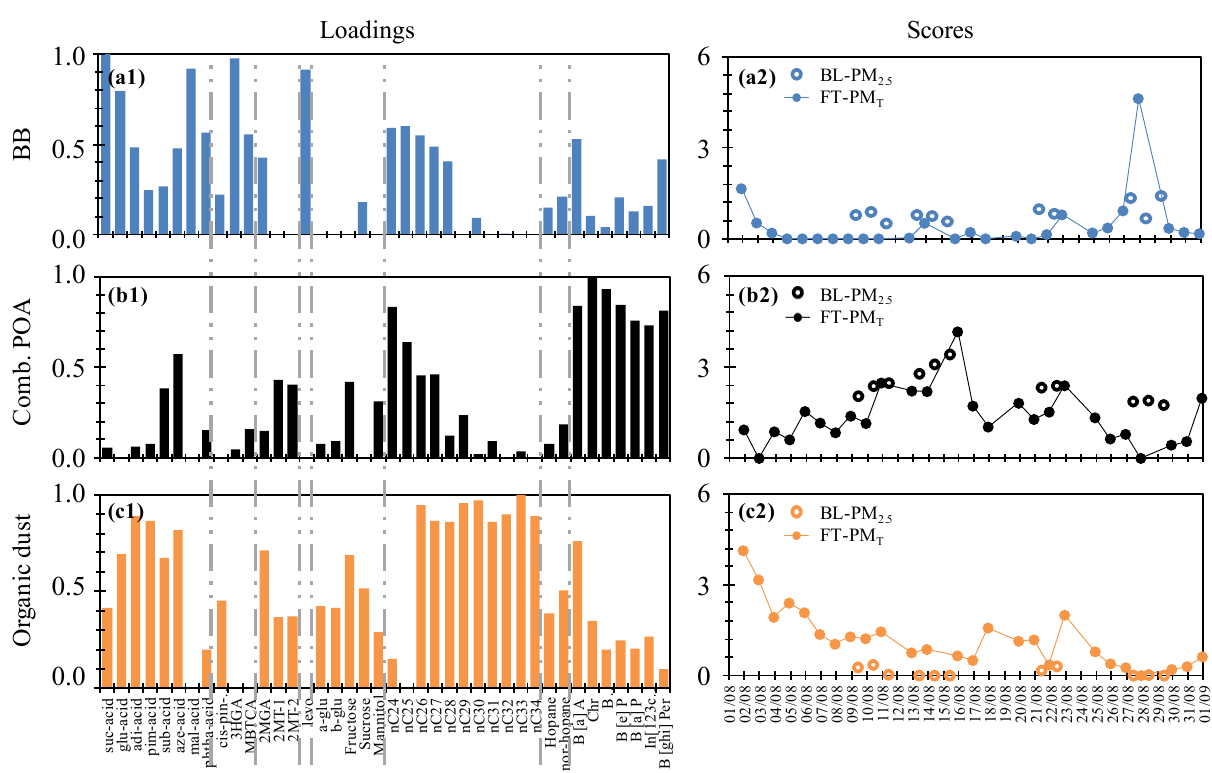
Figure 5. FT-PM T (night) and BL-PM 2 . 5 (day) loadings and scores of the three components from MCR-ALS resolved profiles. Filled markers correspond to FT-PM T and open markers to BL-PM 2 . 5 . Grey lines separate the compounds belonging to the different organic groups: dicarboxylic acids, SOA PIN, SOA ISO, levoglucosan, saccharides, n -alkanes, hopanes and PAHs (from left to